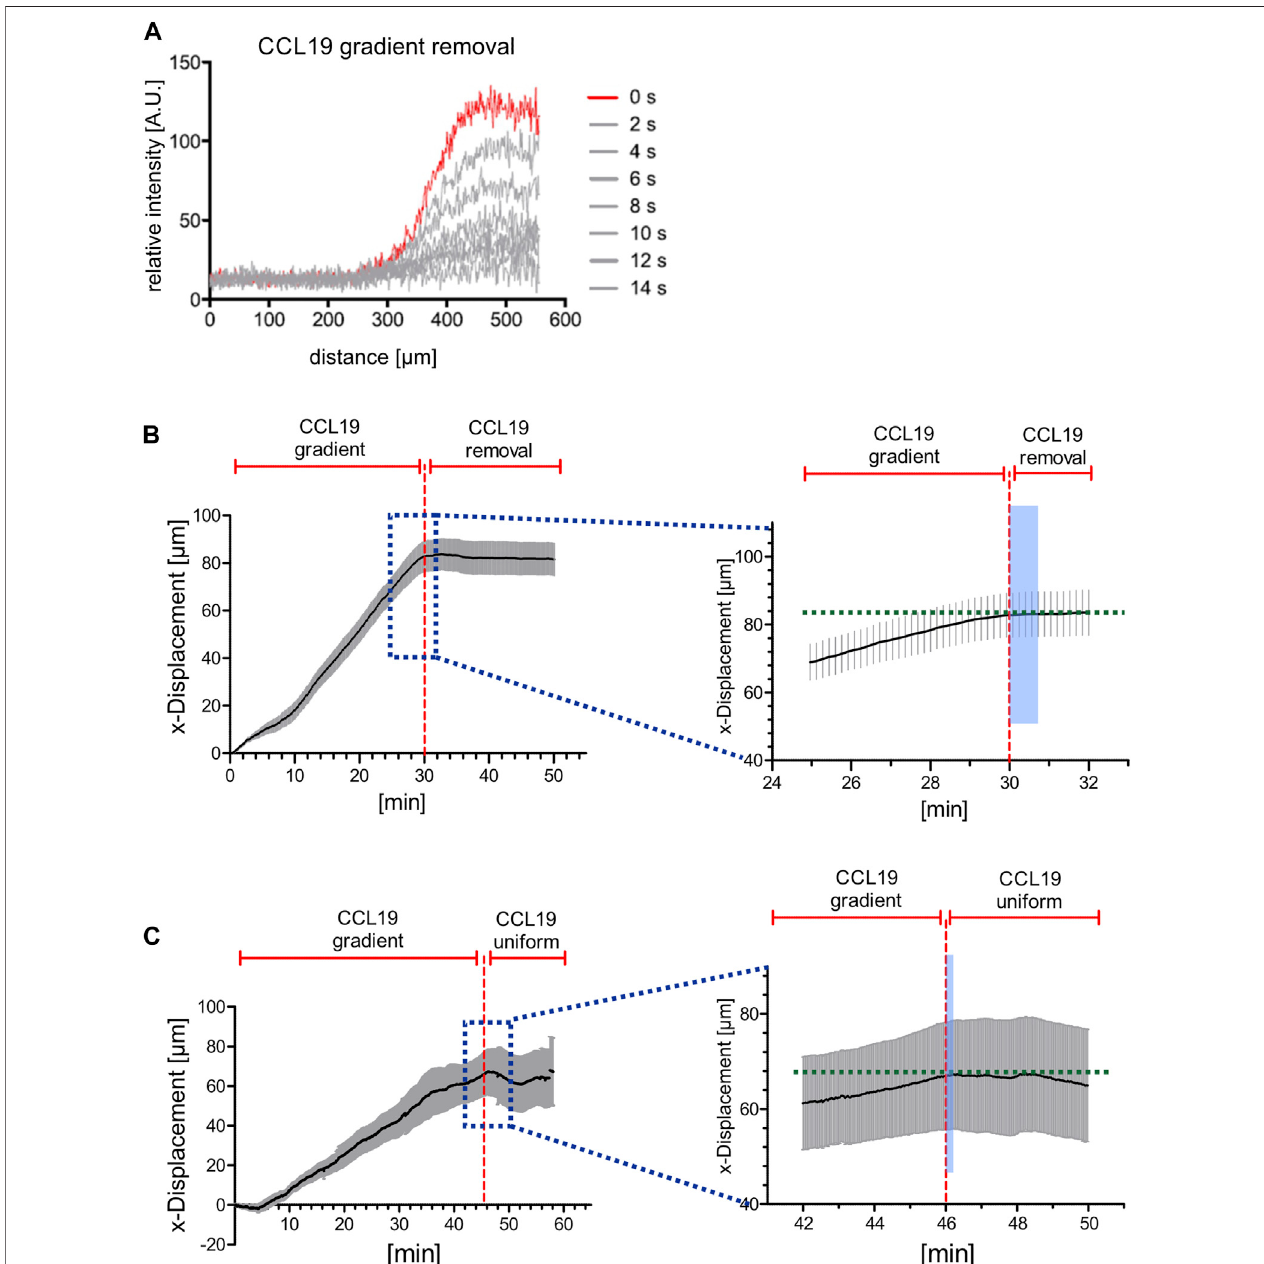
FIGURE 4 | Directional persistent migration of BM-DCs is abrogated in the range of seconds when stable CCL19 gradients are perturbed. (A) Concentration pro fi les of soluble 10 kDa Dextran Alexa Fluor (AF) 647, which is used as a surrogate molecule to mirror CCL19 concentration pro fi les, before (red line, t = 0 s) and after (graylines) fl ow-basedgradientremoval. (B) x-displacementsofmotileBM-DCstowardsastablesolubleCCL19gradientandfollowingCCL19gradientremoval(instant time of gradient abrogation indicated by red dashed line). Stopping time of chemotaxing cells was quanti fi ed by analyzing the stagnation of x-displacement in response to gradient removal (indicated by the light blue area in the right panel, which is an enlarged viewing of the dark blue dotted area in the left panel). (C) x-displacements of motile BM-DCs towards a stable soluble CCL19 gradient and following uniform CCL19 stimulation (instant time of gradient abrogation indicated by red dashed line).Stopping time ofchemotaxing cells wasquanti fi ed byanalyzing thestagnation ofx-displacementinresponsetogradientremoval(indicated bythelight blue area in the right panel, which is an enlarged viewing of the dark blue dotted area in the left panel). (A,B) Representative data from one of three experiments, N = 12 – 15, mean ± SEM. See also Supplementary Videos S3, S4